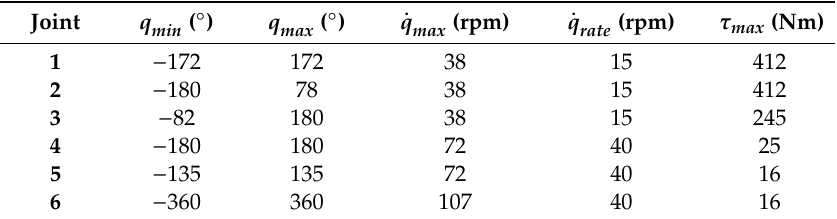
Table 3. Limit on joint displacement, speed and